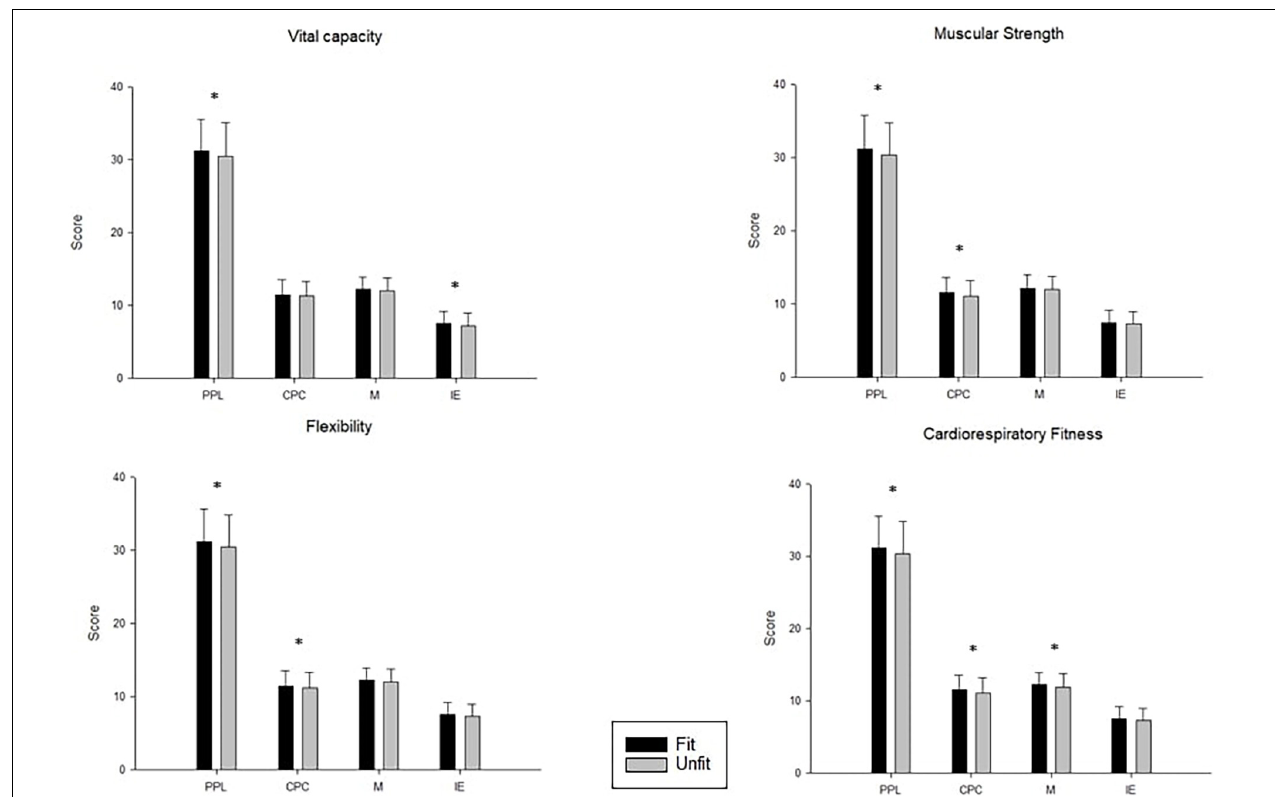
FIGURE 1 | Physical fitness groups (i.e., fit and unfit) and attribute and total physical literacy scores. ∗ p < 0.05.